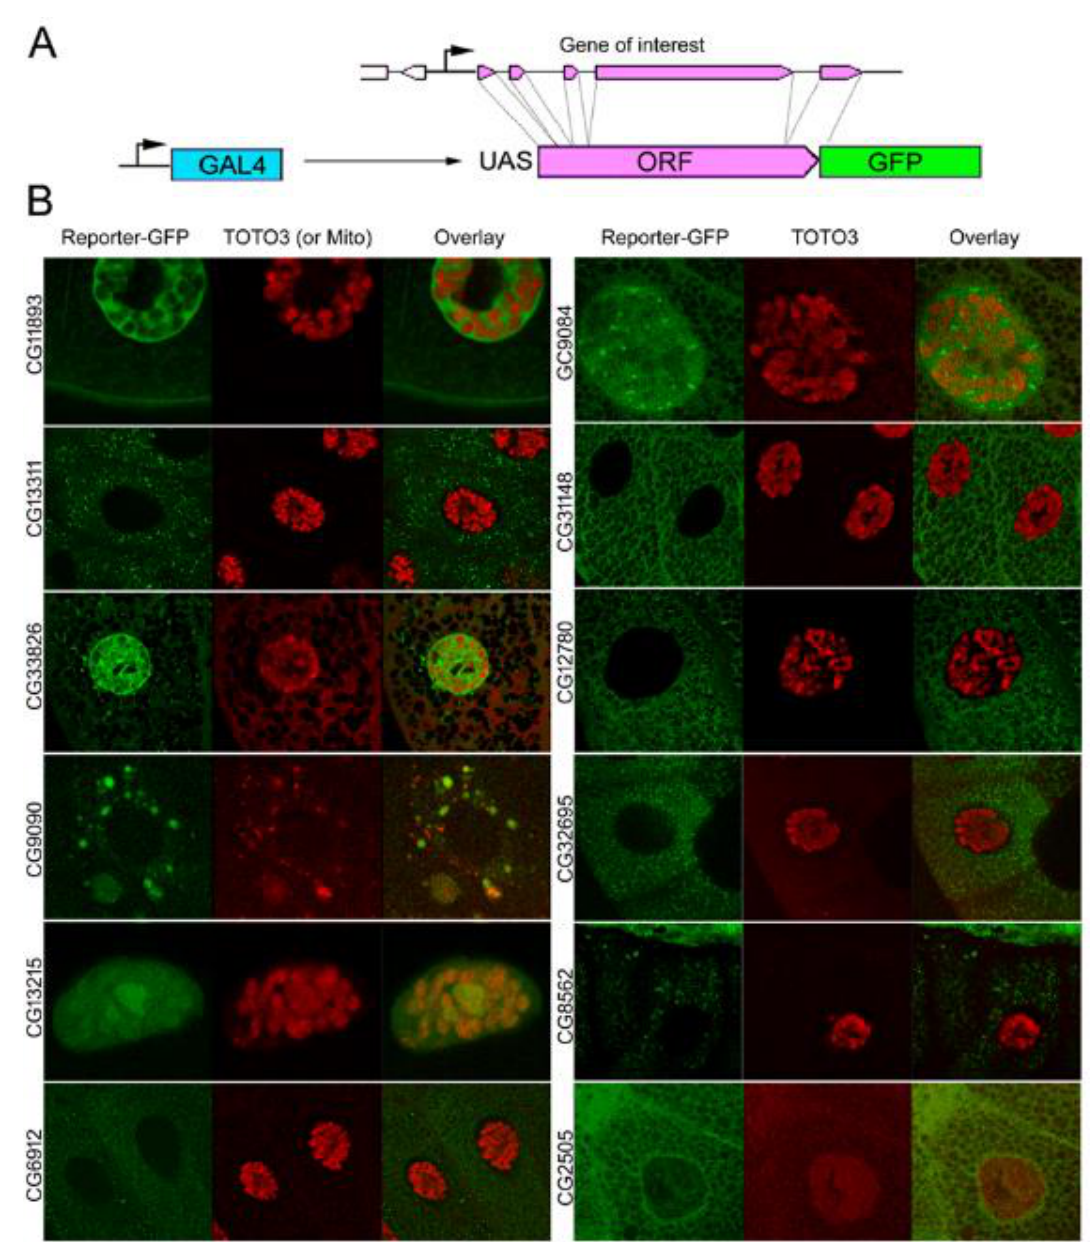
Figure 5. Cellular localization of twelve randomly selected genes out of the list of 232 with unknown function. ( A ) To allow transcription of the recombinant protein under the control of the GAL4 transcriptional factor, we fused cDNAs of these genes with GFP ORF and cloned them into a pUASt vector. ( B ) To study cellular localization and secretion of twelve recombinant proteins, we expressed them in larval salivary glands (SG) using a forkhead-GAL4 driver and examined them using confocal microscopy. Live, dissected larval salivary glands expressing reporter-transgenes (green) were stained with DNA-binding dye (red, shown only in Overlay) and analyzed by confocal microscopy live imaging. A single cell is shown for each experiment. We used TOTO3 staining (red) to detect nuclear DNA (chromatin) (for all except CG9090) and mitochondrial protein Tim17b (red) (for CG9090). We distinguished localization of the following proteins using morphology and co-staining: soluble nucleoplasm, chromatin, nucleolus, nucleoplasmic granules; soluble cytoplasm, secretory granules, mitochondria, perinuclear and peri-plasma membrane space and secreted when recombinant proteins accumulate in SG